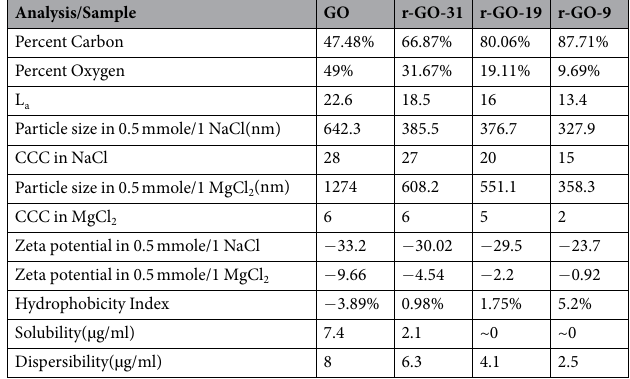
Table 1. Properties of GO and r-GOs produced via stepwise reduction.